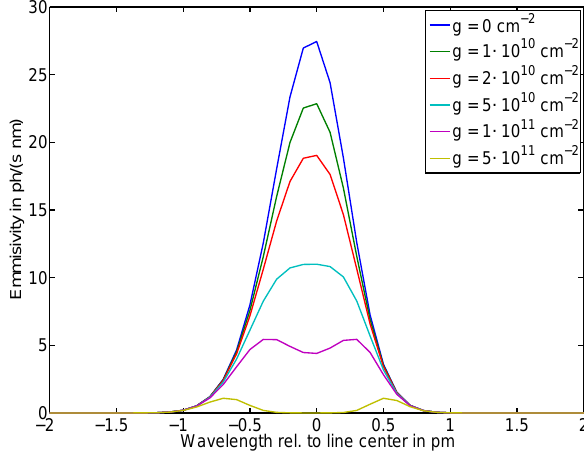
Fig. 16. Absorption cross section for the Mg 285.2nm line (black line and left-hand ordinate), which has to be multiplied with the attenuated solar irradiance (other lines and right-hand ordinate) to obtain the wavelength-specific emissivities shown in Fig. 17. The initial incoming light is partly absorbed along the line from Sun (LFS) before the absorption and re-emission process into the line- of-sight (LOS). After this it is further absorbed along the LOS. Only a small part of the light on the LFS is absorbed and emitted into the LOS. However, this just leads to a constant scaling for the remaining light before and after the resonance fluorescence process and the shape of the spectrum stays the same. Therefore, the parts of g from the LOS and the LFS may not be treated separately. The initially as constant approximated irradiance profile is absorbed where the cross section is high. This leads to a spectral hole burning.